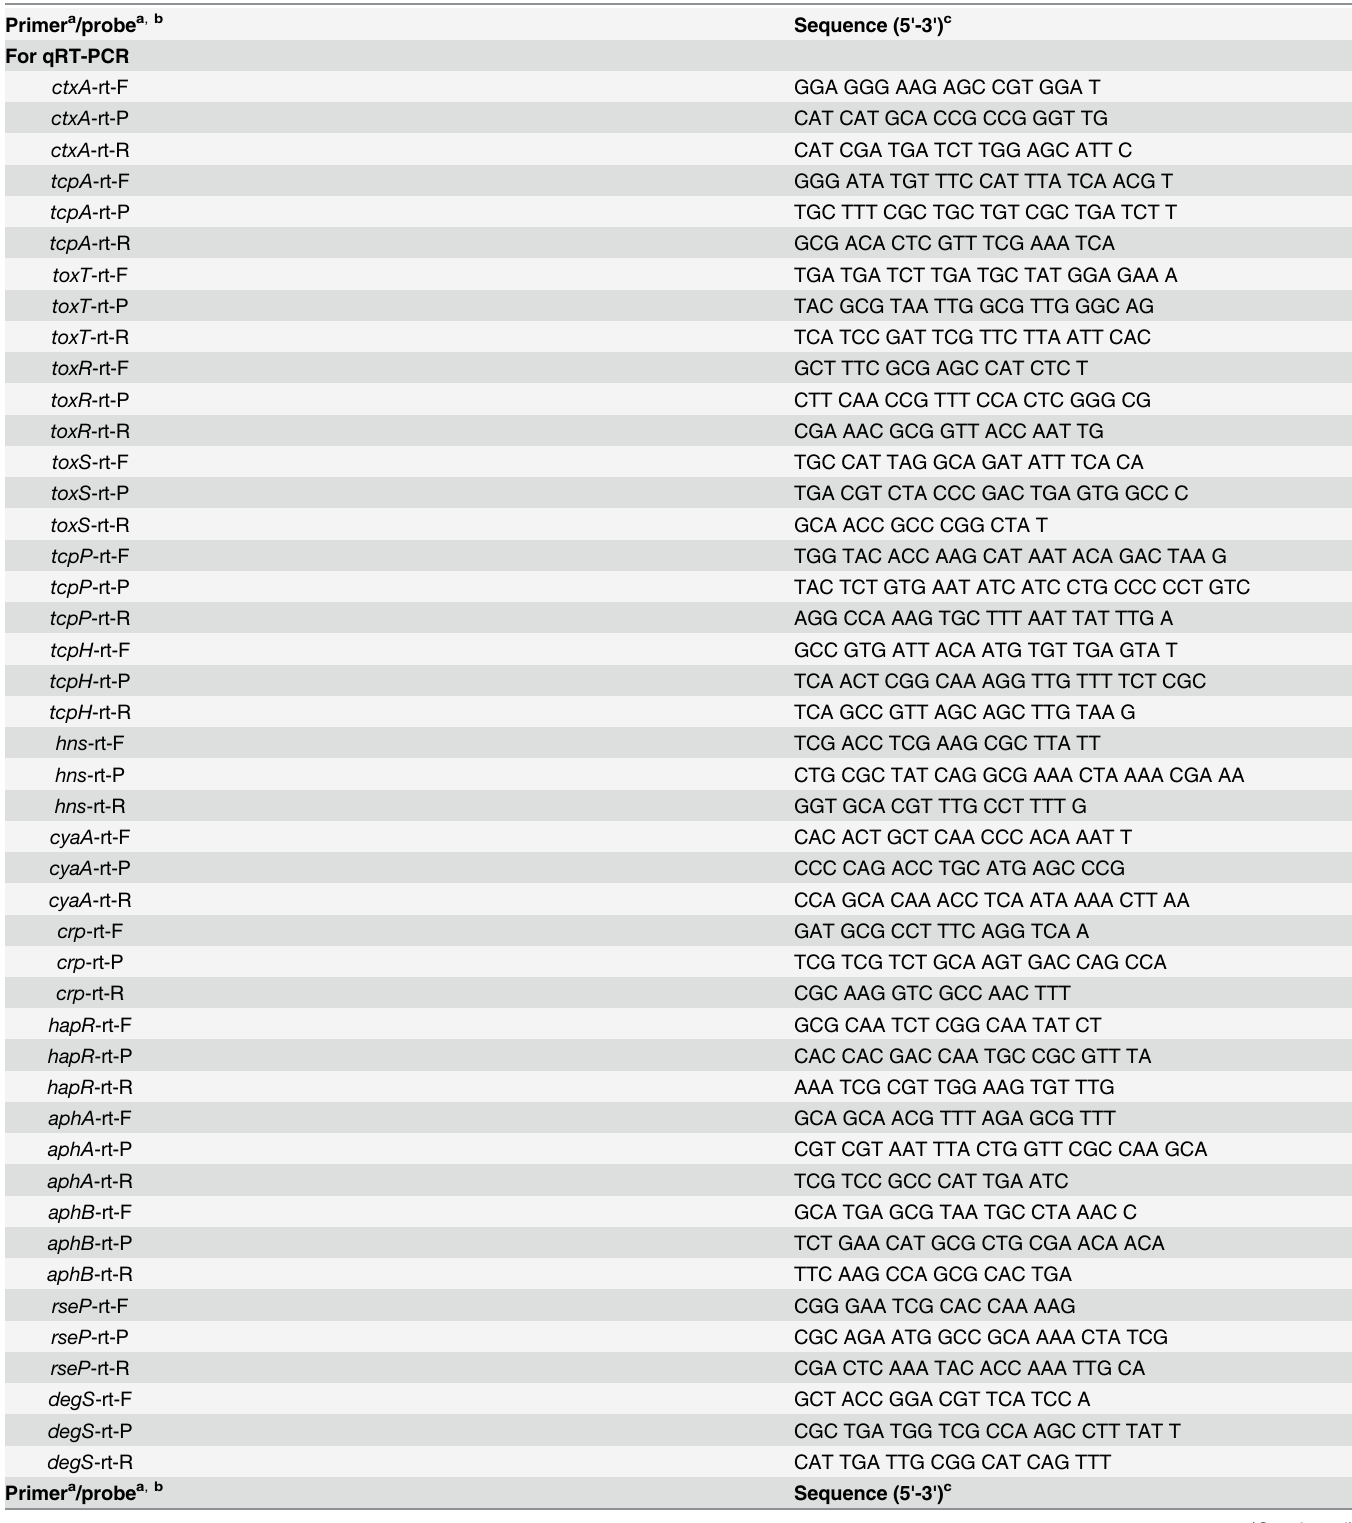
Table 2. Sequences of oligonucleotides used in this